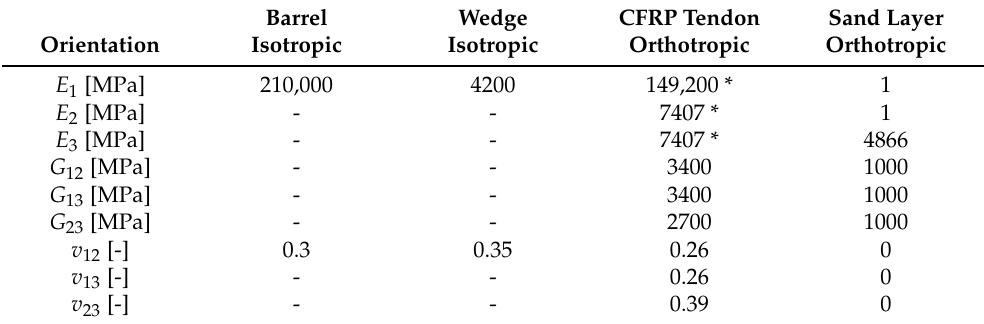
Table 5. FE Model Parameters (* measured